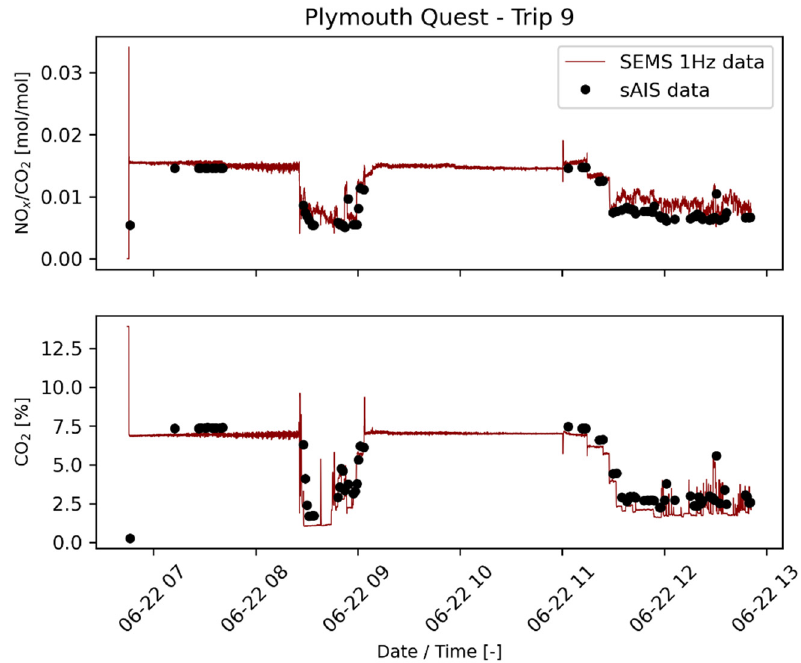
Figure 9. Comparison of SEMS 1 Hz data and S-AIS data on RV Plymouth Quest (Trip 9).